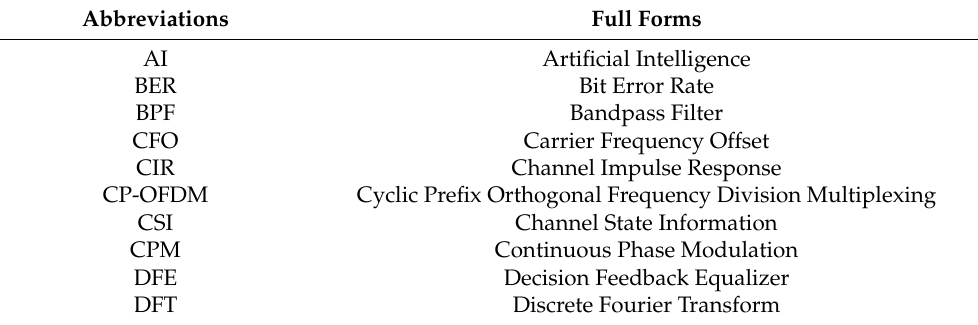
Figure 1. Outline of UWA physical layer technologies, channel problems, and challenges. Table 1. List of